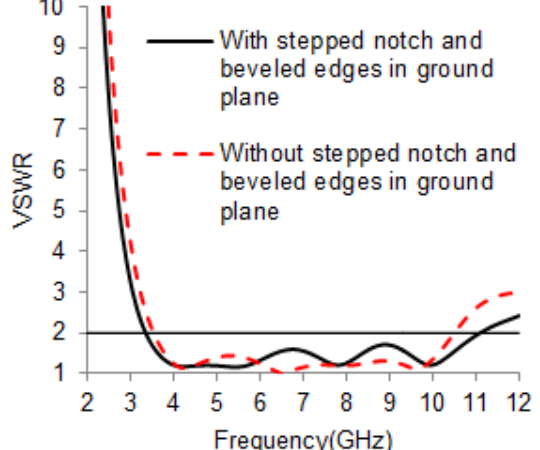
Figure 2: Comparison of VSWRs against frequency for basic hammer-shaped UWB antenna with and without stepped notch and beveled edges.